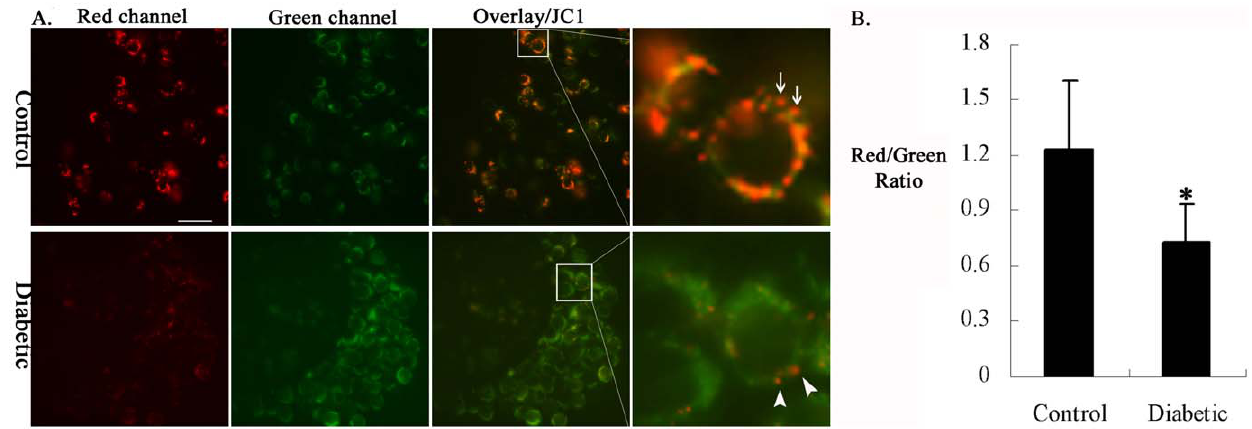
Figure 2. Decreased mitochondrial membrane potential in cumulus cells of diabetic mice. Cumulus-oocyte complexes from control and diabetic mice were stained with JC-1 to evaluate mitochondrial membrane potential ( Dy m ) by fluorescence microscopy. Representative images of cumulus cells are shown. (A) Generally, mitochondria in cumulus cells of control mice were predominantly in red form (arrows), indicating the high Dy m . In contrast, the loss of red fluorescence and thus increased green mitochondria were observed in cumulus cells of diabetic mice (arrowheads), indicating the low Dy m . (B) Histogram shows the ratio of red to green fluorescence intensity calculated to characterize Dy m . Note the decreased Dy m in cumulus cells of diabetic mice. Error bars indicate 6 SD. * p , 0.05 vs controls. Scale bar: 20 m m.